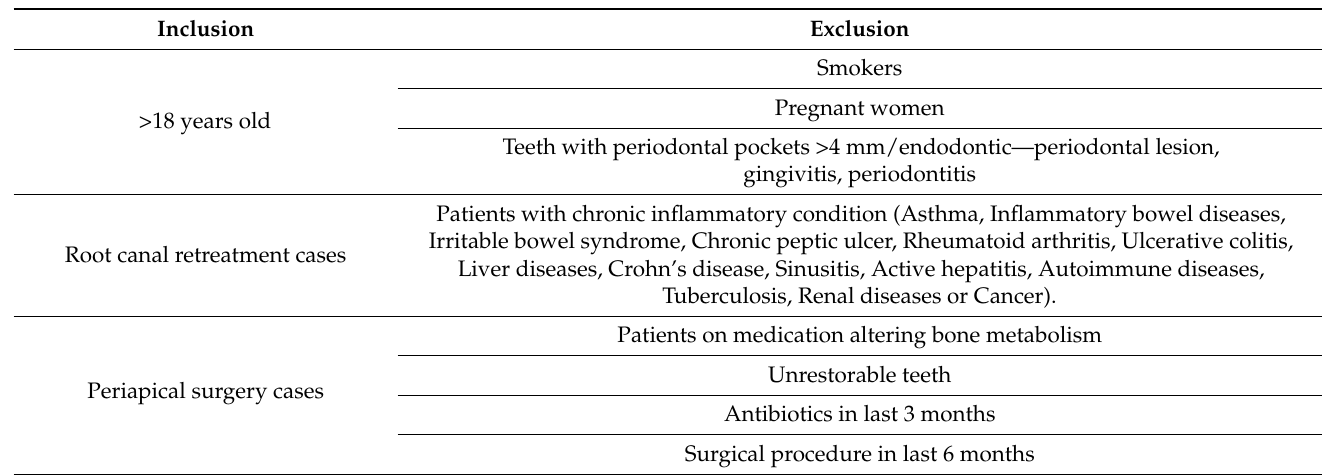
Table 1. Inclusion and exclusion criteria